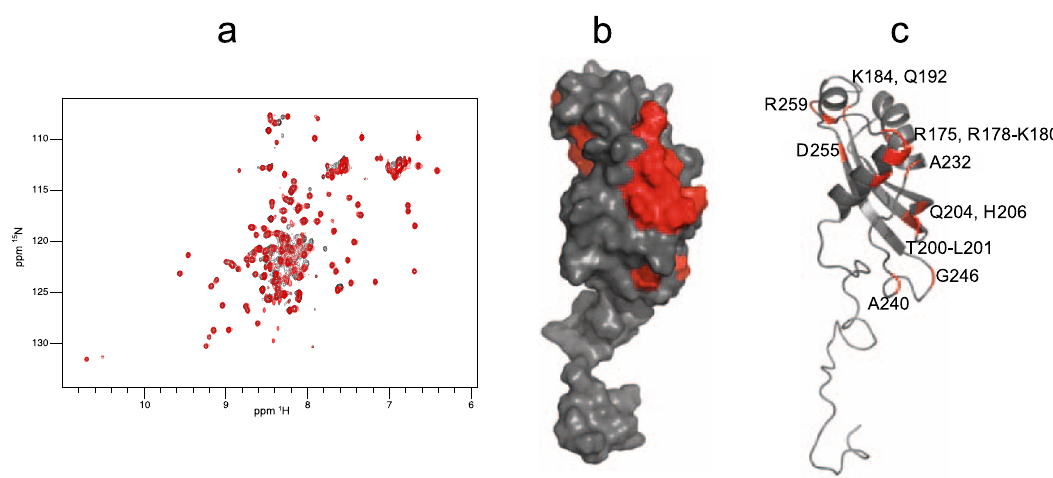
Fig. 4 Interaction of HasB CTD with the periplasmic fragment of ExbB Sm , as detected by NMR. a Superposed 1 H – 15 N HSQC spectra of 0.15 mM 15 N-labeled HasB CTD in 50 mM sodium phosphate, pH 7, 50 mM NaCl in the presence (red) or absence (black) of the periplasmic peptide of ExbB Sm residues 1 – 44. b , c HasB CTD residues (PDB code 2M2K) exhibiting the highest CSP in the presence of the periplasmic peptide of ExbB sm are colored red ( b : surface representation; c : cartoon representation). The residues showing the highest CSP are